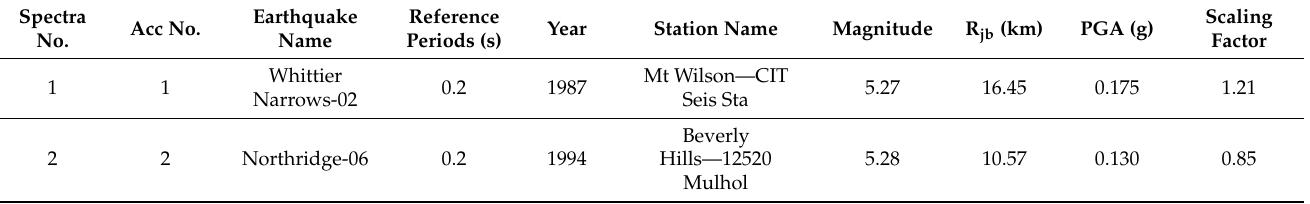
Table A3. Summary of the 24 earthquake records selected from the PEER